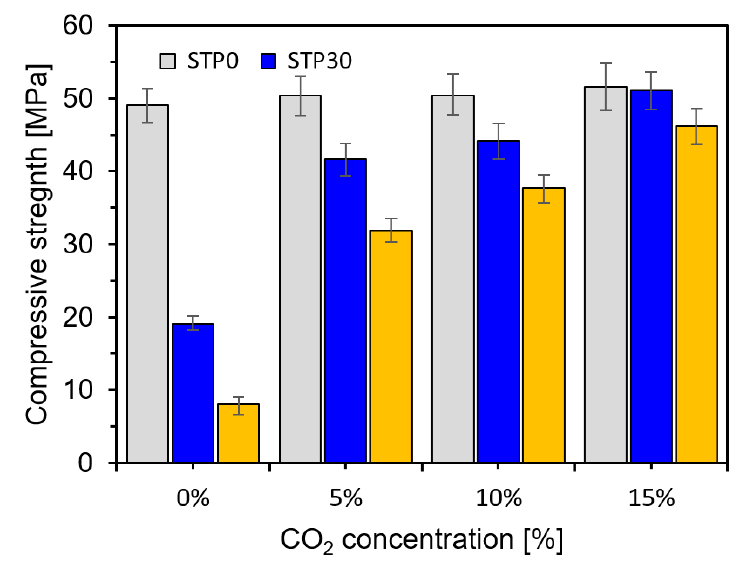
Figure 3. Compressive strength of specimens according to CO 2 concentration.